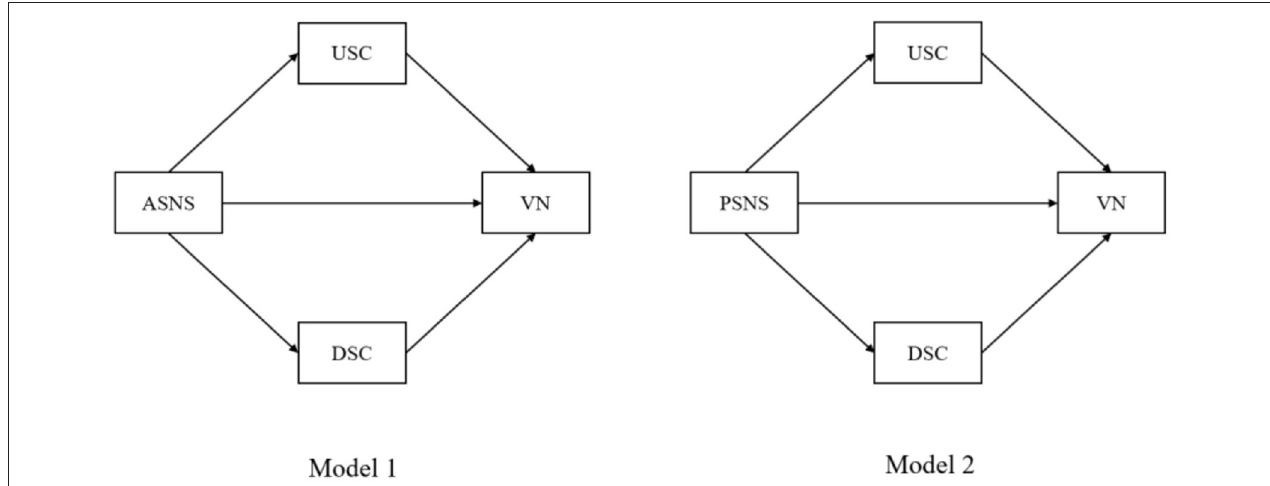
FIGURE 1 | Conceptual model. ASNS, Active social networking sites; PSNS, Passive social networking sites; USC, Upward social comparison; DSC, Downward social comparison; VN, Vulnerable narcissism.